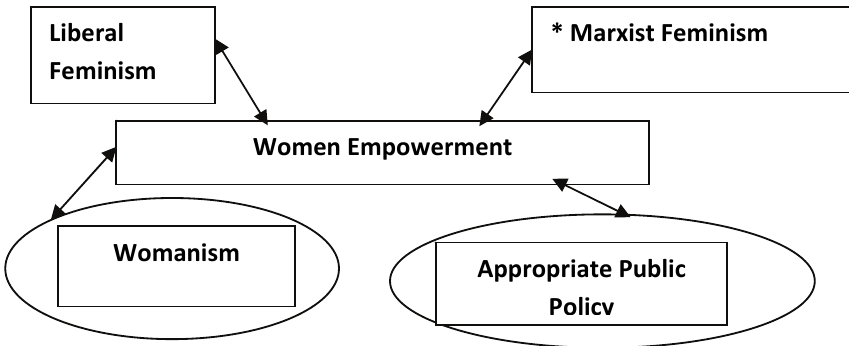
Figure 1: The Relationship between Feminist Theories and Women Empowerment